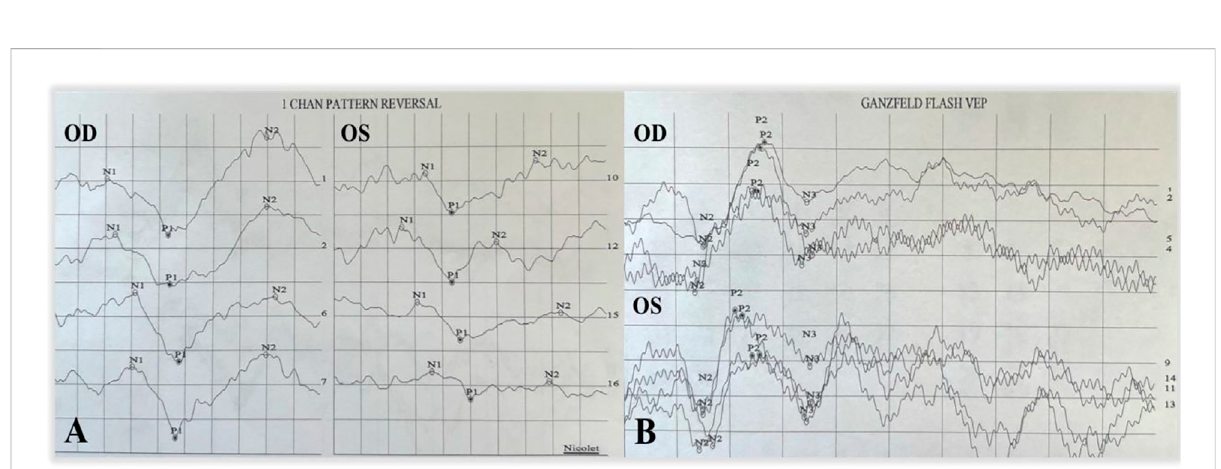
FIGURE 3 P-VEPandF-VEPoftheproband.ThelatencyofthewaveformrecordedbyP-VEPinbotheyeswasdelayedathighSF,whichwasobviousinthe right eye, and the amplitude decreased at high SF, mild in the left eye, and obvious in the right eye (A) . The amplitude of the waveform recorded by F-VEP was similar in both eyes (B)